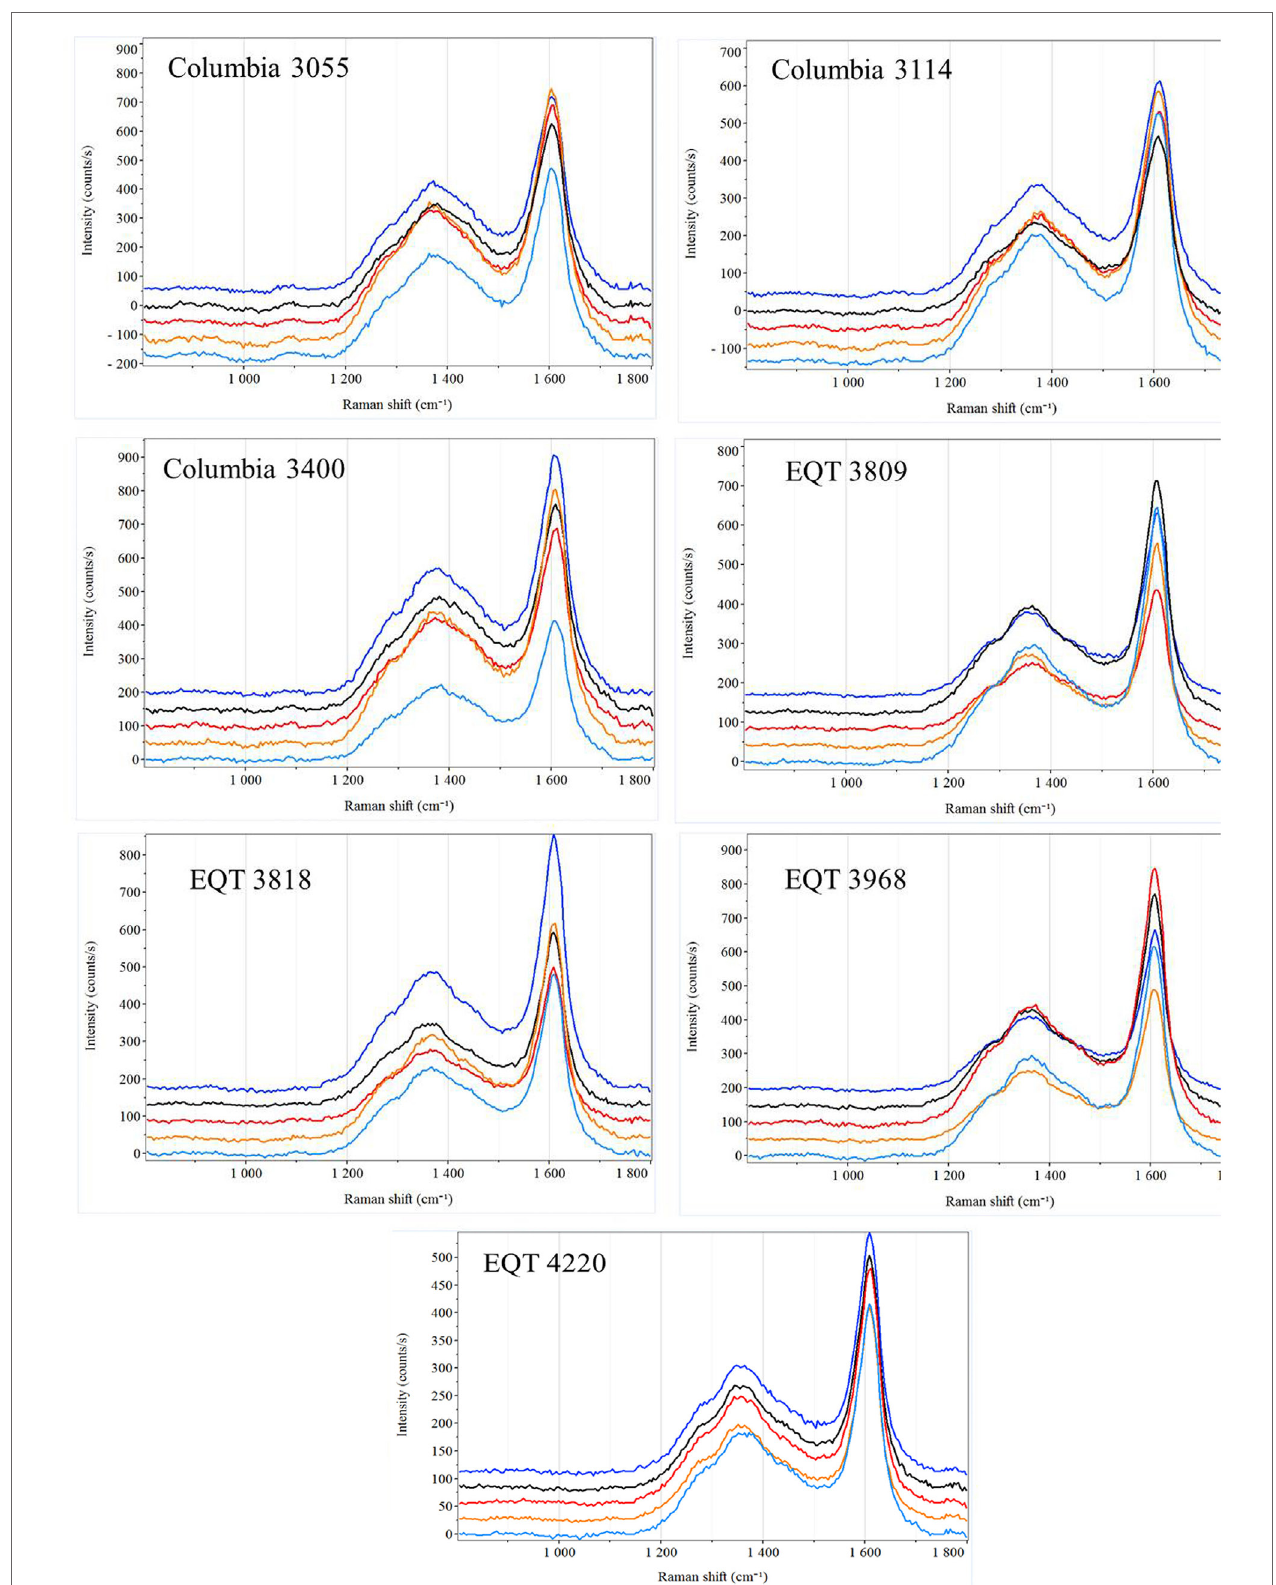
FigUre 2 | Averaged Raman spectra of 13 shale samples used for peak-fitting. The 100 data points were divided into sets of 20, producing five averaged spectra per sample. Each of the five averaged spectra was individually peak-fit, and the resultant Raman correlations have been provided with corresponding standard deviations.